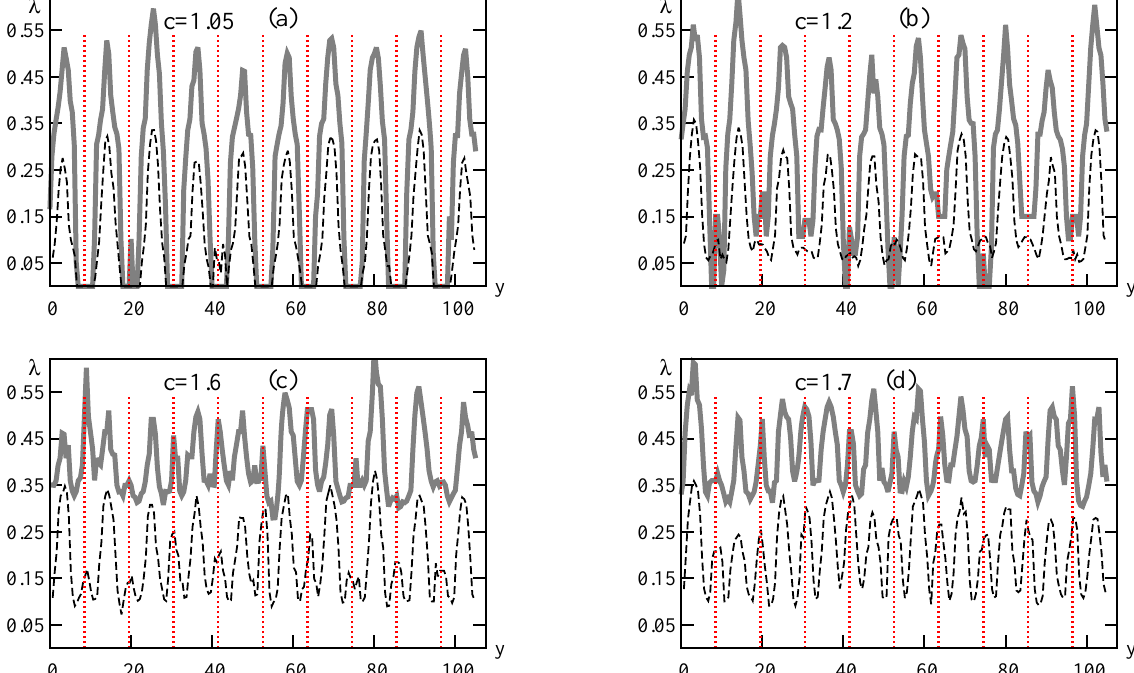
Figure 7. The irregularity index computed in 4-year sliding windows for synthetic data averaged over 162 (solid gray) and 648 (dashed black) days ( m =2). Model parameters are: a =0.8, h =0.4, k =0, and c =1.05 (a) , 1.2 (b) , 1.6 (c) and 1.7 (d) . Red dashed vertical lines at solar sunspot minima.